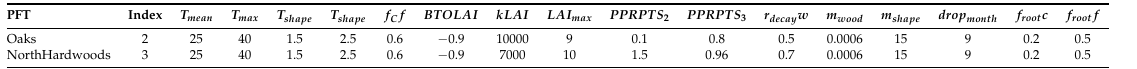
Table A12. Functional group parameters.